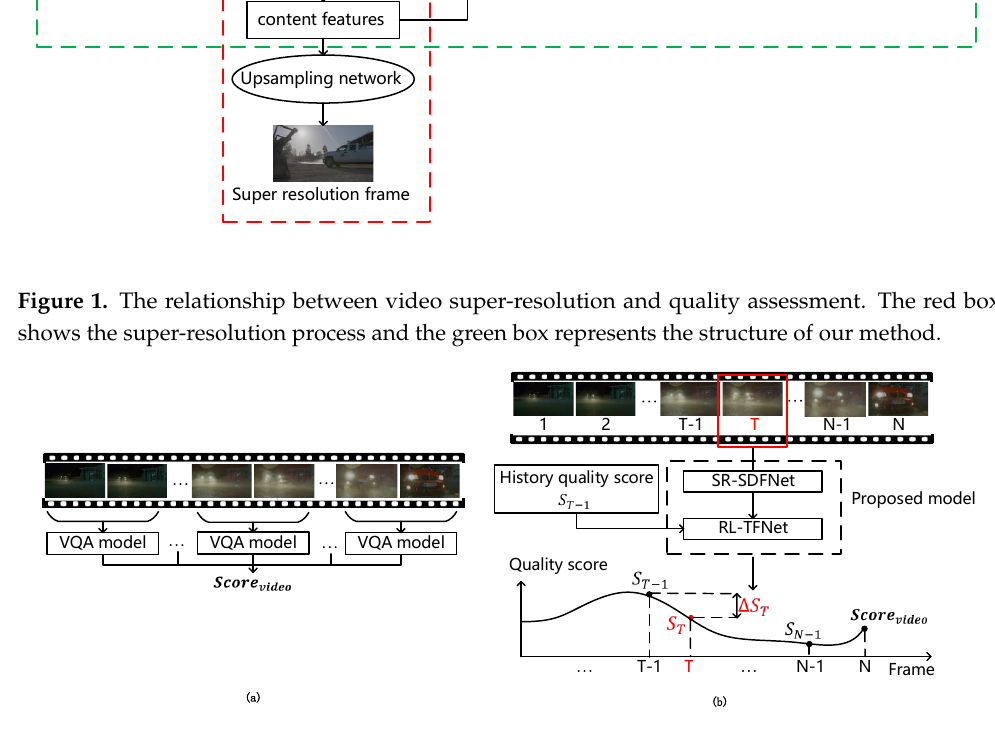
Figure 2. ( a ) Video quality score prediction process of previous NR − VQA methods. ( b ) Video quality score prediction process of our